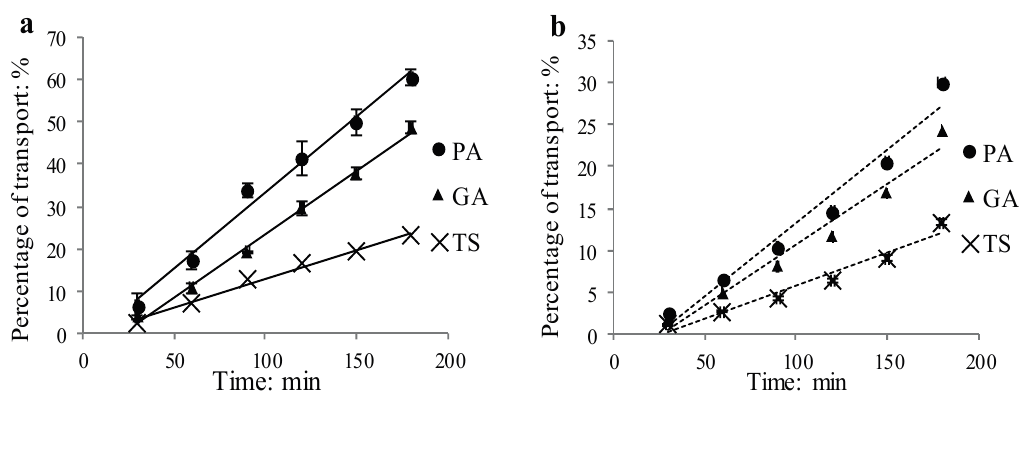
Figure 3. Transport of three phenolic acids across Caco-2 cell monolayer as the function of time at 50 μ mol/L ( a ) AP to BL side; ( b ) BL to AP side (means ± SD, n =